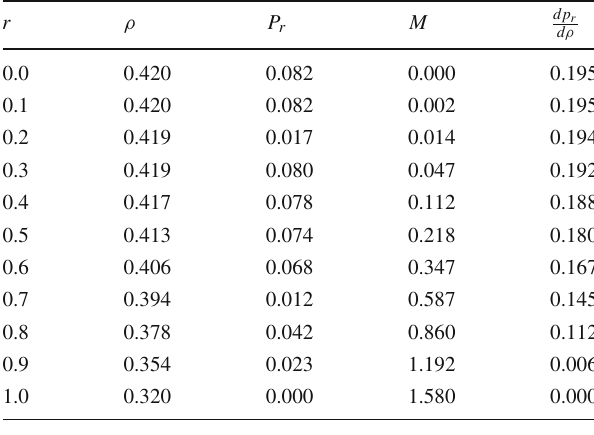
Table 2 Energy density (ρ) , radial pressure ( P r ) and mass ( m ) varia- tion from center to boundary of realistic star 4U 1820-30